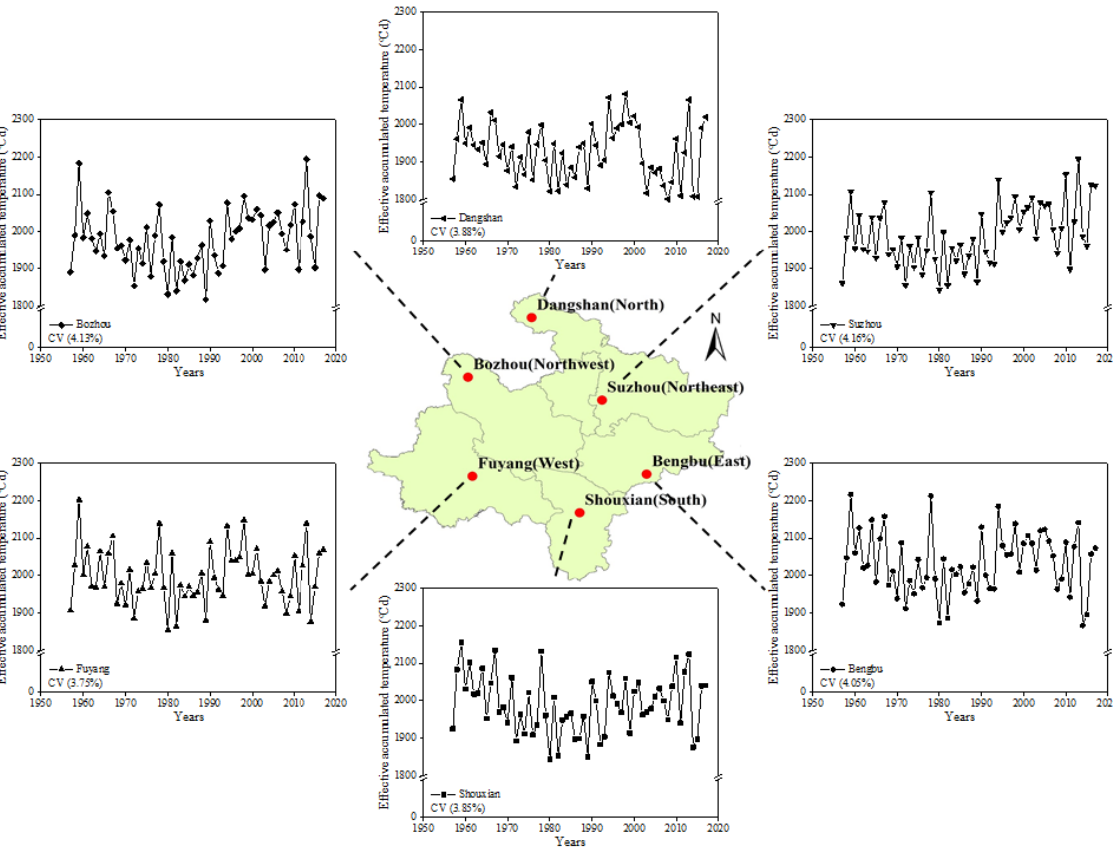
Figure 2. Interannual variation of effective accumulated temperature from 10 June to 30 September corresponding to the summer maize growing season in the past 61 years (1957 – 2017) for six sites, i.e., Shouxian, Bengbu, Fuyang, Suzhou, Bozhou, and Dangshan, on Huaibei Plain, China.